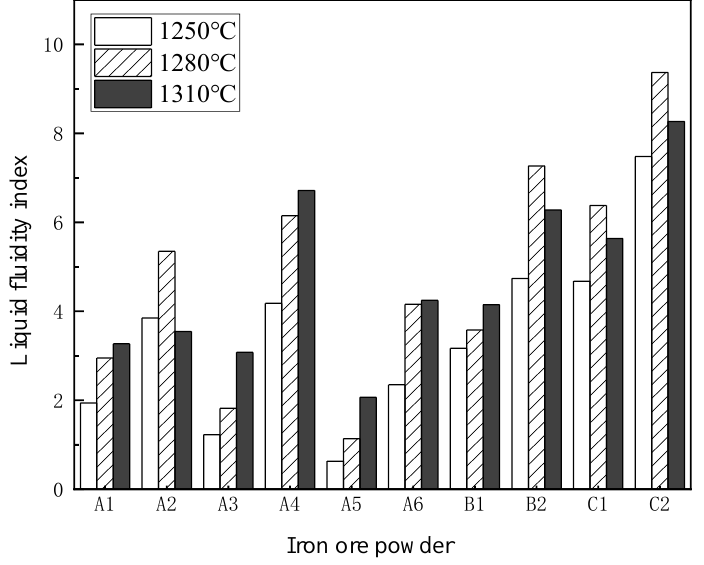
Figure 3. Liquid fluidity index of iron ore powders.